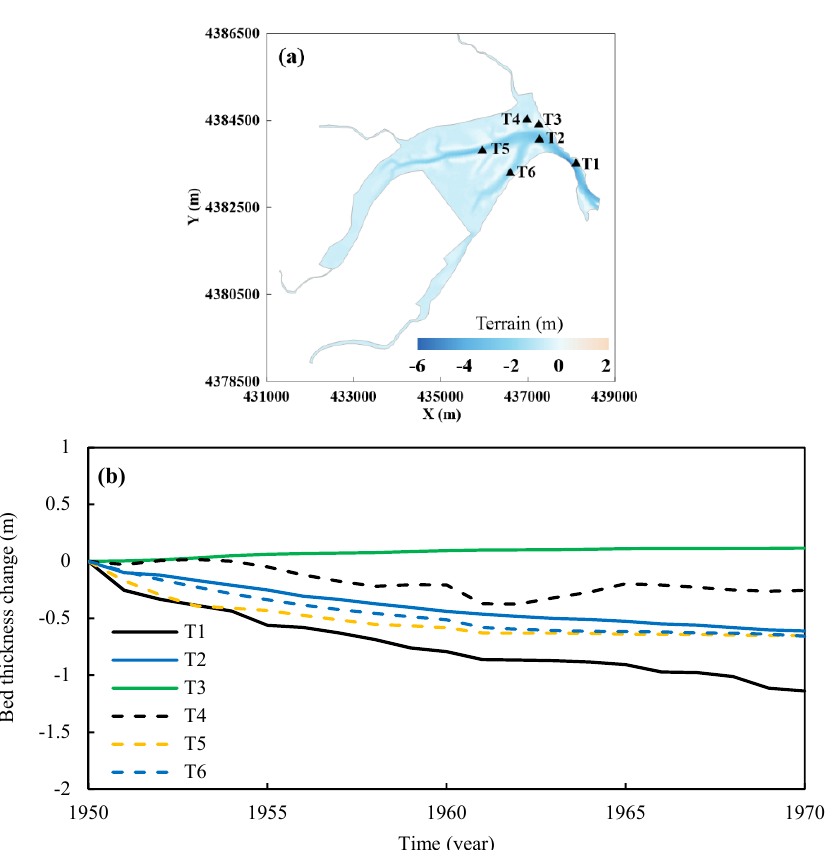
Figure 7. ( a ) Field observation stations: T1 (tidal inlet); T2 (creek A); T3 (tidal flat); T4 (creek D); T5 (creek C); T6 (creek B). ( b ) Bed thickness changes at the observation stations T1 to T6 from 1950 to 1970.